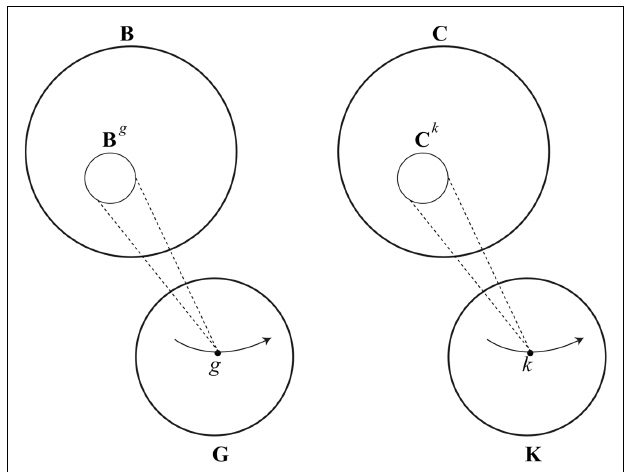
FIGURE 3 | Space of brain structures G, states of background knowledge K, and corresponding “accessible” regions of the space of brain states B and conscious states